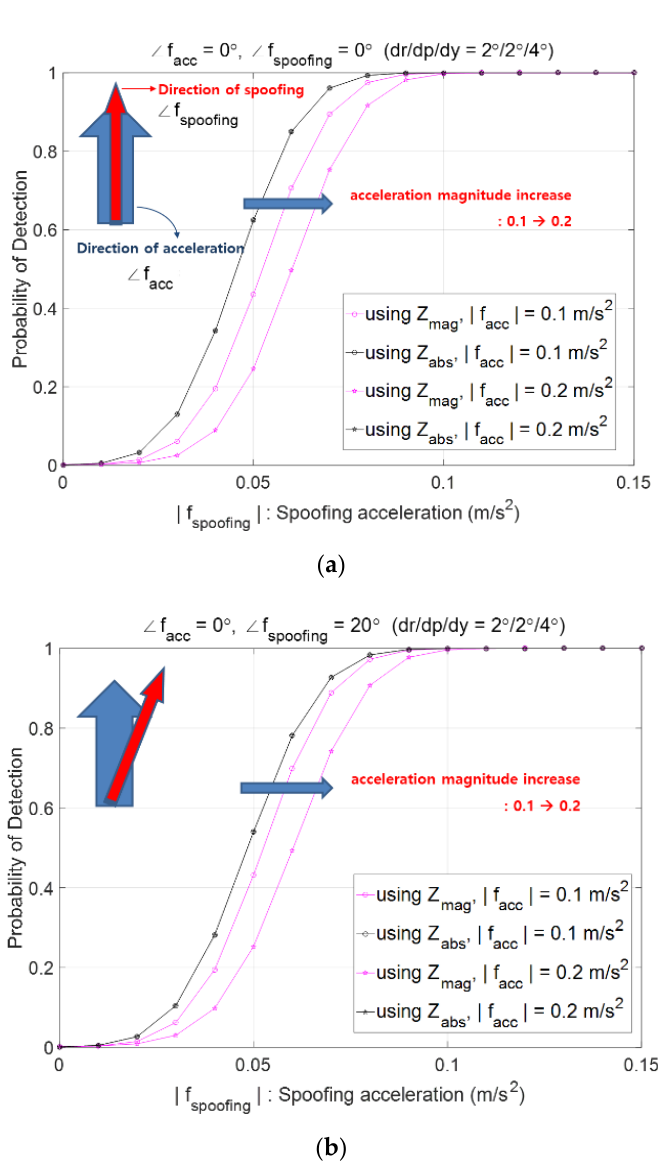
Figure 4. Probabilities of spoofing detection, P d , mag and P d , absN when ( a ) Both f acc and f s are heading north, ( b ) f acc is heading north and f s heading northeast 20 ◦ (arrow in cyan: moving acceleration f acc , narrow arrow in red: spoofing acceleration f s